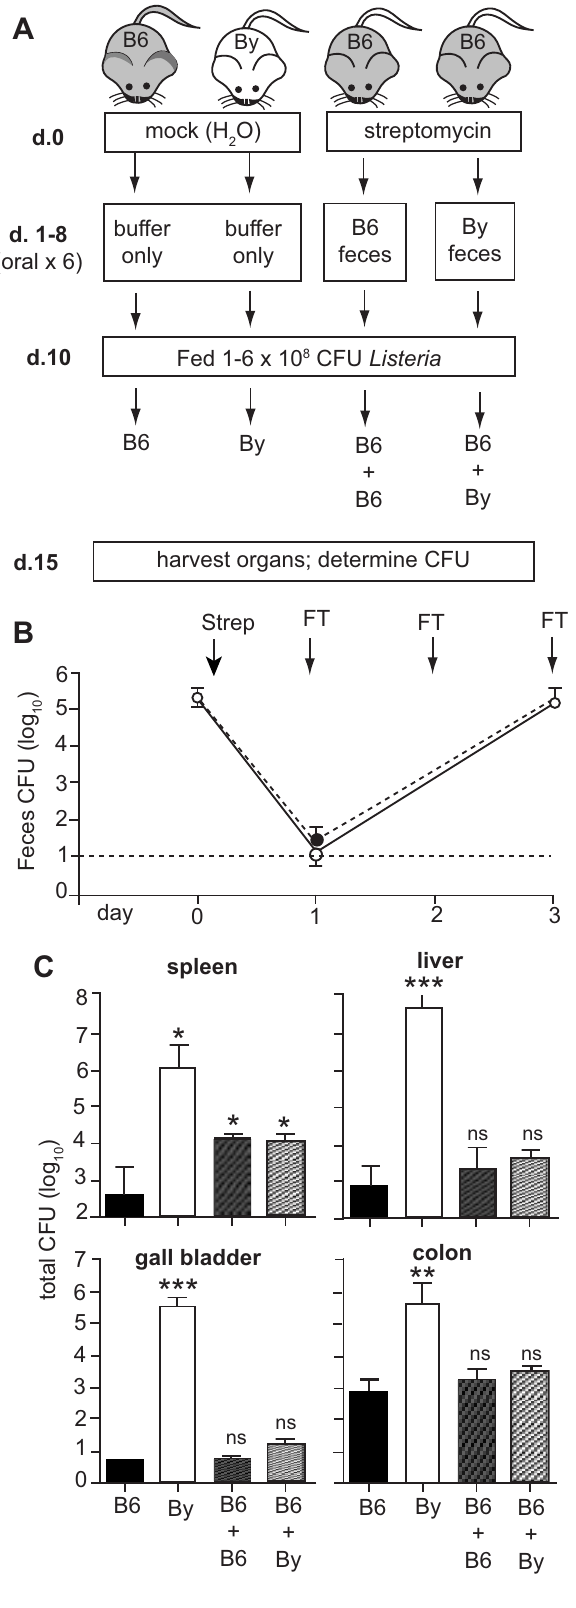
Figure 2. Transplantation of fecal matter from BALB/c/By (By) mice to C57BL/6 (B6) mice does not enhance susceptibility to food borne listeriosis. ( A ) The experimental design for four groups of mice is shown. Mock-treated mice received oral treatments with buffer alone and maintained their original microbiota. Streptomycin- treated mice received a total of 6 fecal transfers over an 8 day period. On day 9, food was restricted and all mice were placed on raised wire flooring for the duration of the experiment. ( B ) The efficiency of the streptomycin pre-treatment was evaluated by monitoring the amount of aerobic CFU shed in the feces. Mean values ± SEM for groups of 8 mice are shown. Arrows indicate days of either antibiotic treatment (Strep) or fecal transfers (FT). ( C ) Mean values ± SEM (n=8) for total L. monocytogenes CFU in spleen, liver, or gall bladder and the cell-associated CFU in the colon were determined 5 days post infection. Asterisks indicate mean values significantly different from the mock-treated C57BL/6 group as determined by unpaired t-test. Pooled data (n=8) from two separate experiments (n=4 per group in each) is